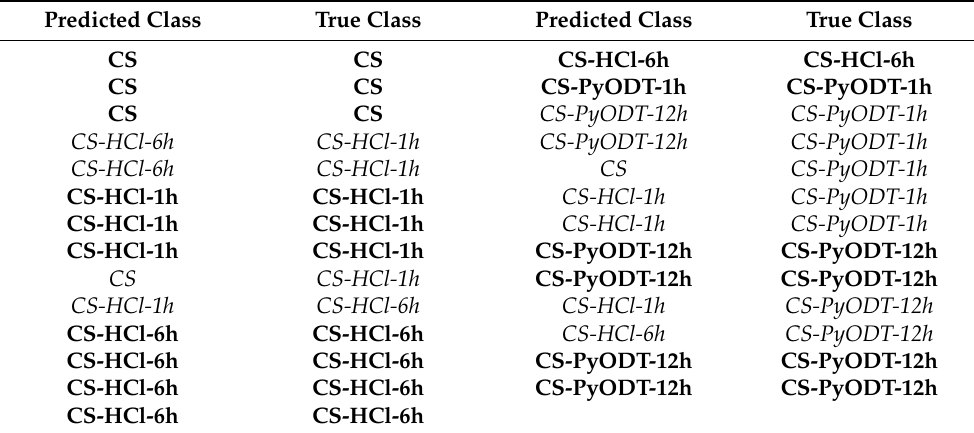
Table 5. C-steel surface analysis: results obtained to evaluate the best-performing model (KNN) on the testing dataset. Predicted Class True